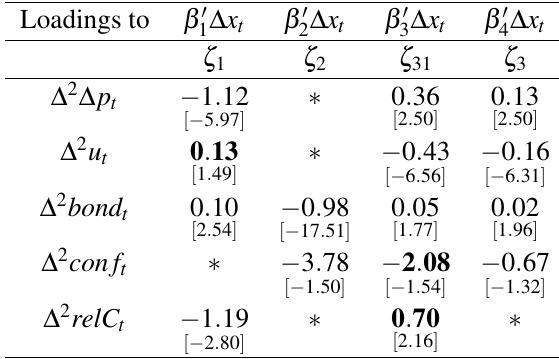
Table 4: The estimated coefficients to the medium-run